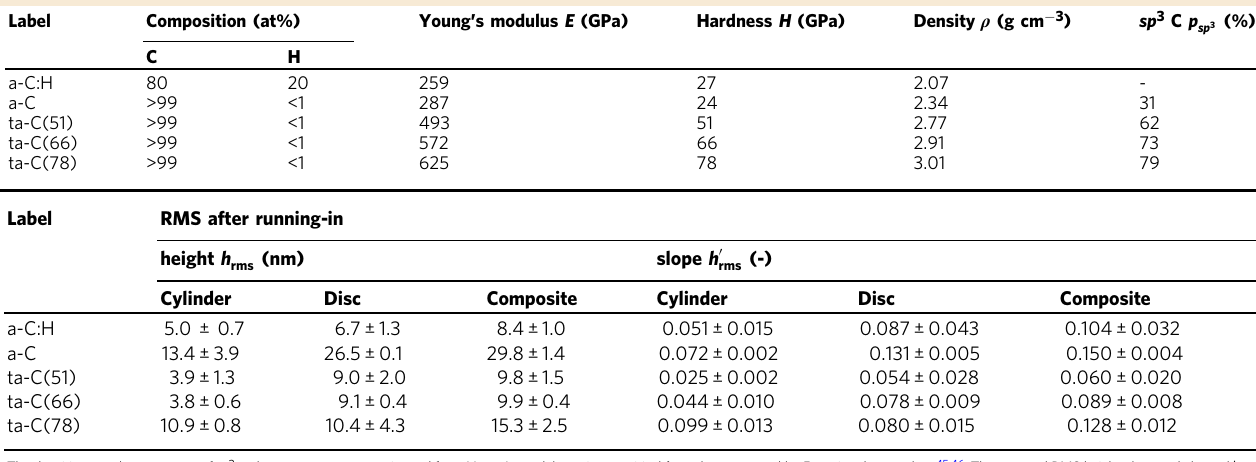
Table 1 Chemical compositions, mechanical and structural properties, and surface roughness parameters of the DLC coatings as used in this